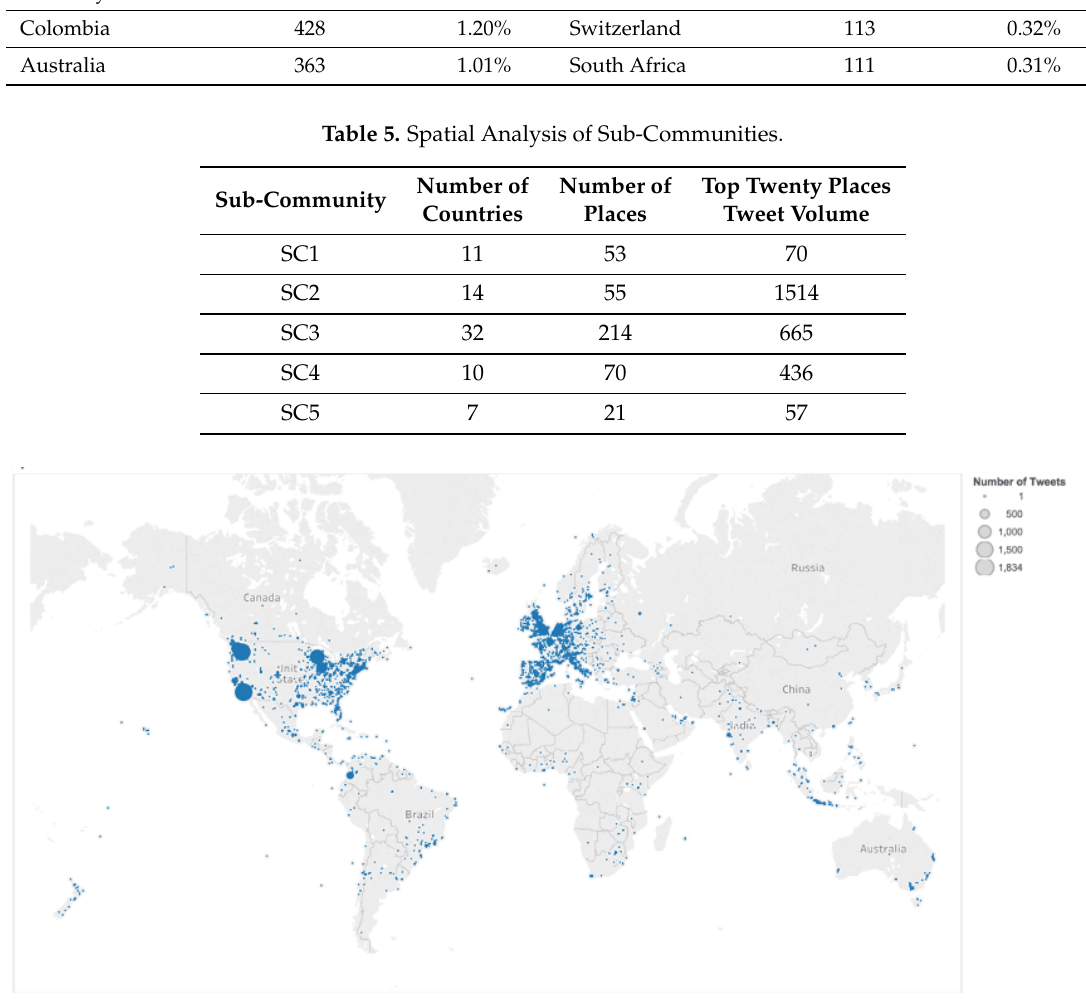
Figure 3. Spatial Visualization of